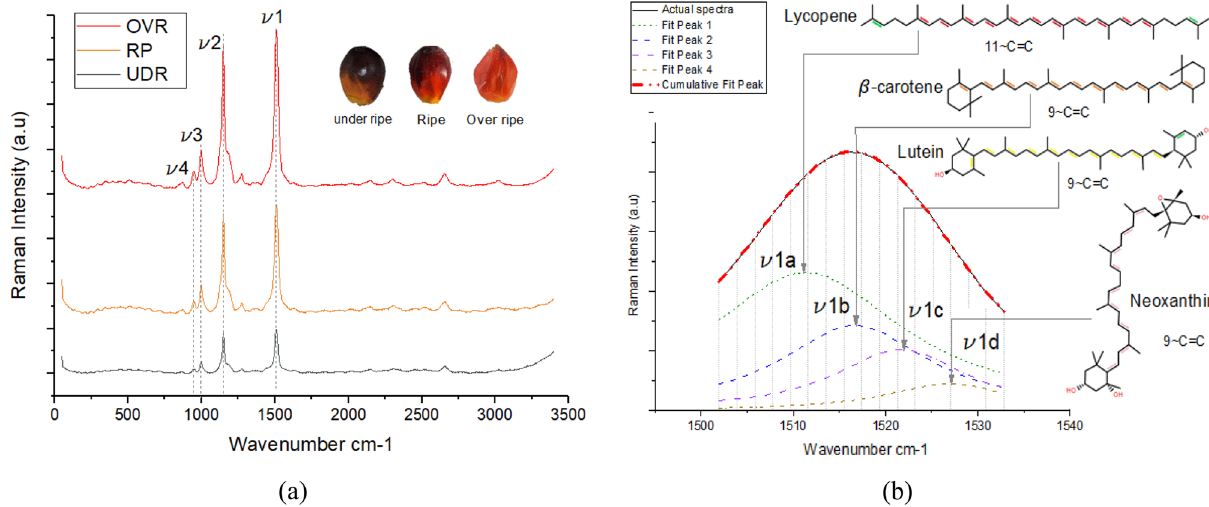
Figure 1. ( a ) Oil palm fruit Raman spectra of 3 levels of ripeness ( OVR over ripe, RP ripe, UDR under ripe). ( b ) Deconvolution results for C=C stretching vibration band and its sub band molecular